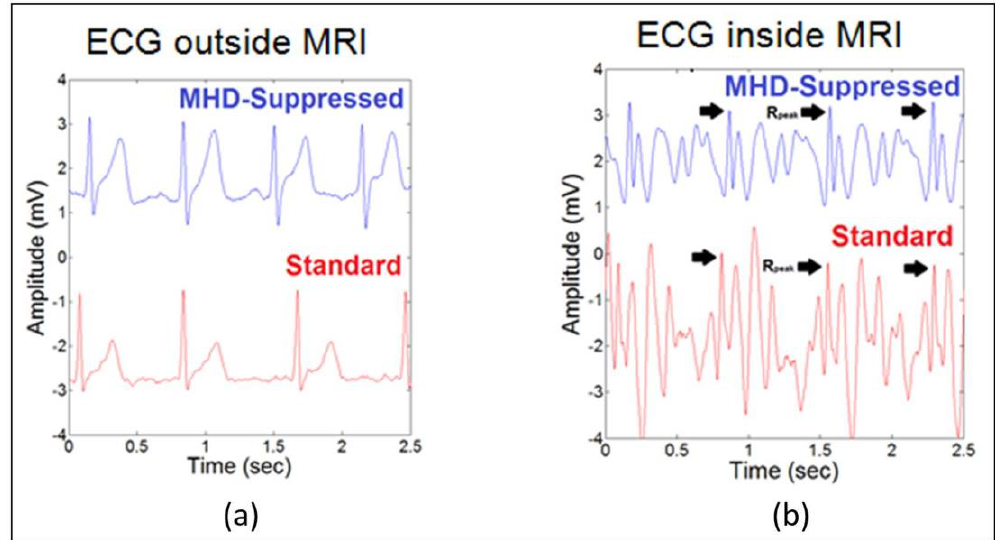
Figure 4. ECG recordings using the standard and V MHD -minimized electrode placements illustrating a decrease in V MHD amplitude in the case of the V MHD -minimized placements. ( a ) Four-lead ECG recordings obtained outside the MRI bore with the standard and V MHD -minimized electrode locations (lead II). R peak in the V MHD -minimized case was found to have a <5% deviation from the standard placement. ( b ) Four-lead ECG recordings obtained inside the MRI bore with the standard and V MHD -minimized electrode locations (lead II). V MHD was reduced by 43.41% with the V MHD -minimized placement compared to the standard placement. Table 2. Evaluation of magnetohydrodynamic (MHD) reduction in each subject for QRS complex detection.